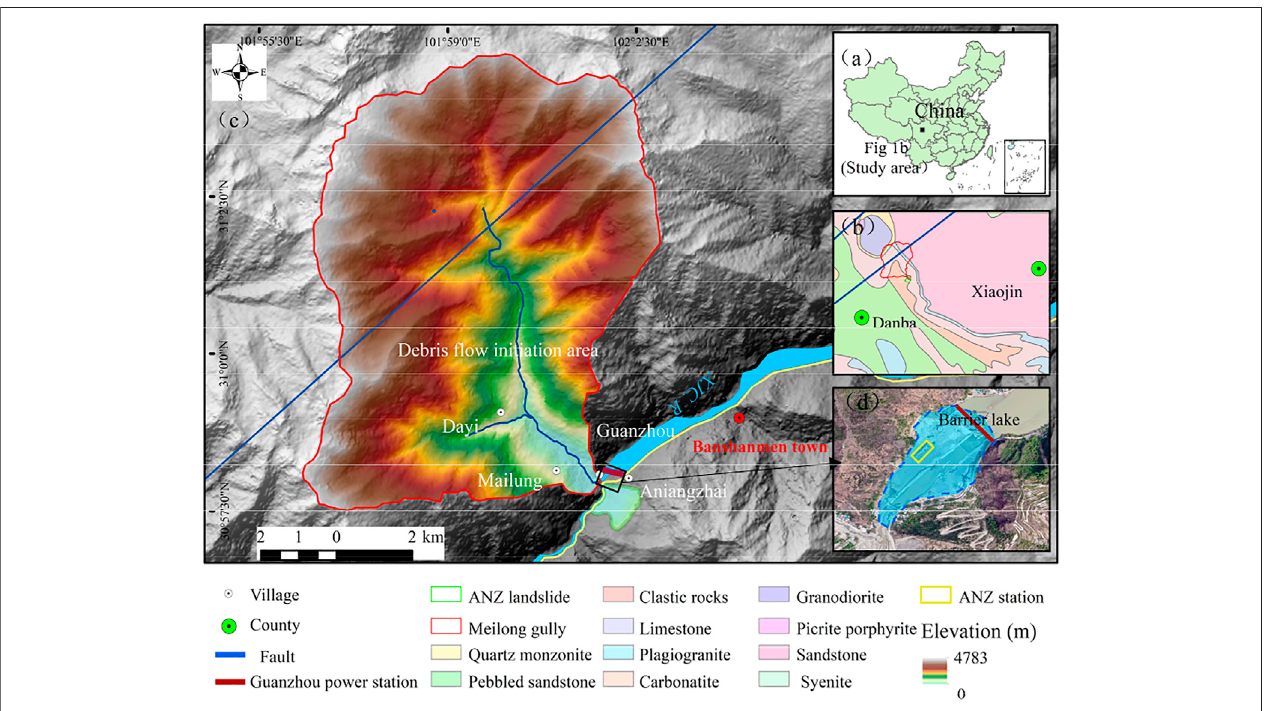
FIGURE 1 | Regional settings and locations of the Meilong valley and ancient ANZ landslide. (A) Location of the study area. (B) Lithology of the study area. (C) Topographic features and fault distribution. (D) Meilong barrier lake. XJC R is the Xiaojinchuan River. ANZ L is the Aniangzhai landslide.